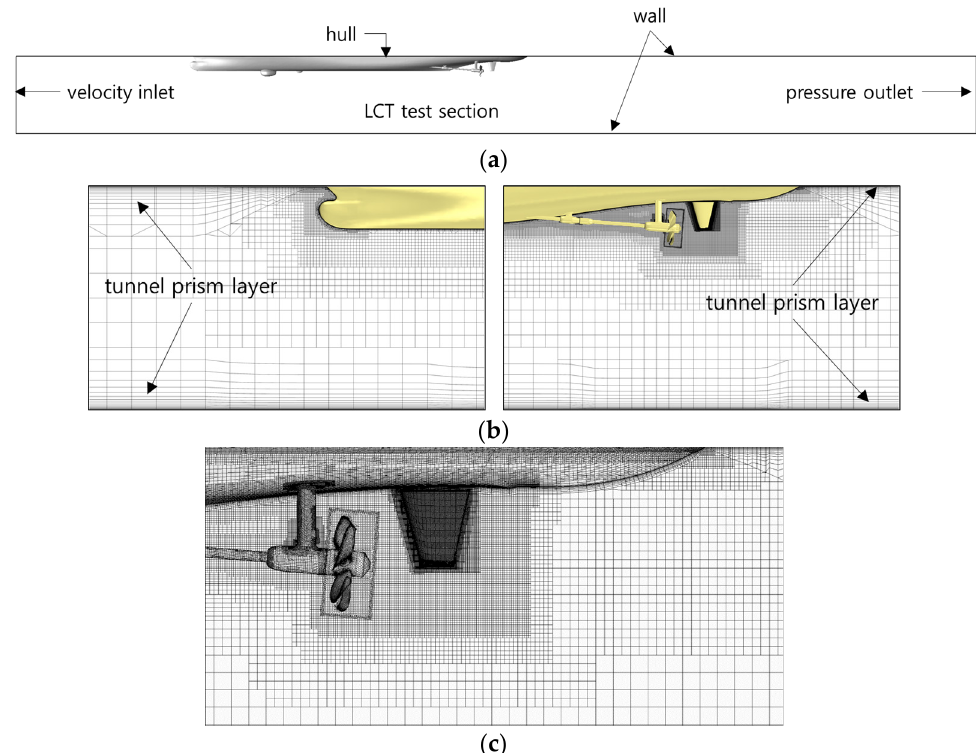
Figure 11. Computational domain and boundary conditions for numerical simulation and mesh strategy for the cavitation tunnel walls and full-appended hull. ( a ) computational domain, ( b ) tun- nel prism mesh layer, and ( c ) mesh distribution around the stern.